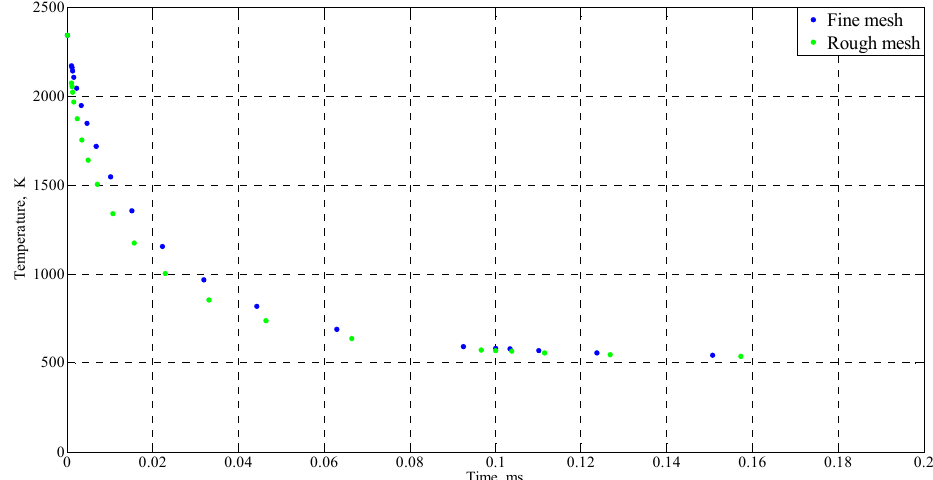
Figure 18. Temperature evolution in the centre of the splat surface for a fine and a rough mesh.